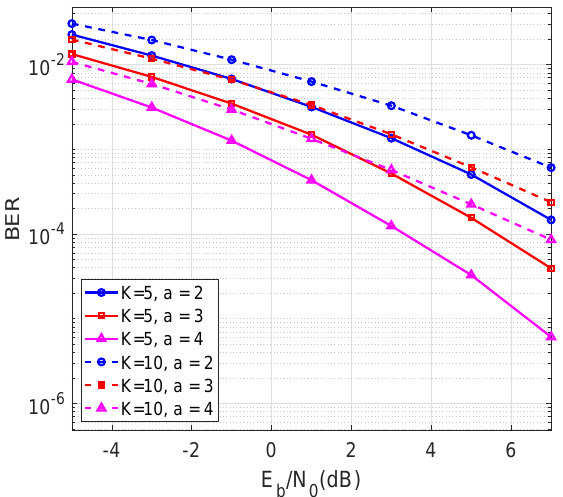
Figure 6. BER of proposed scheme for different values of K